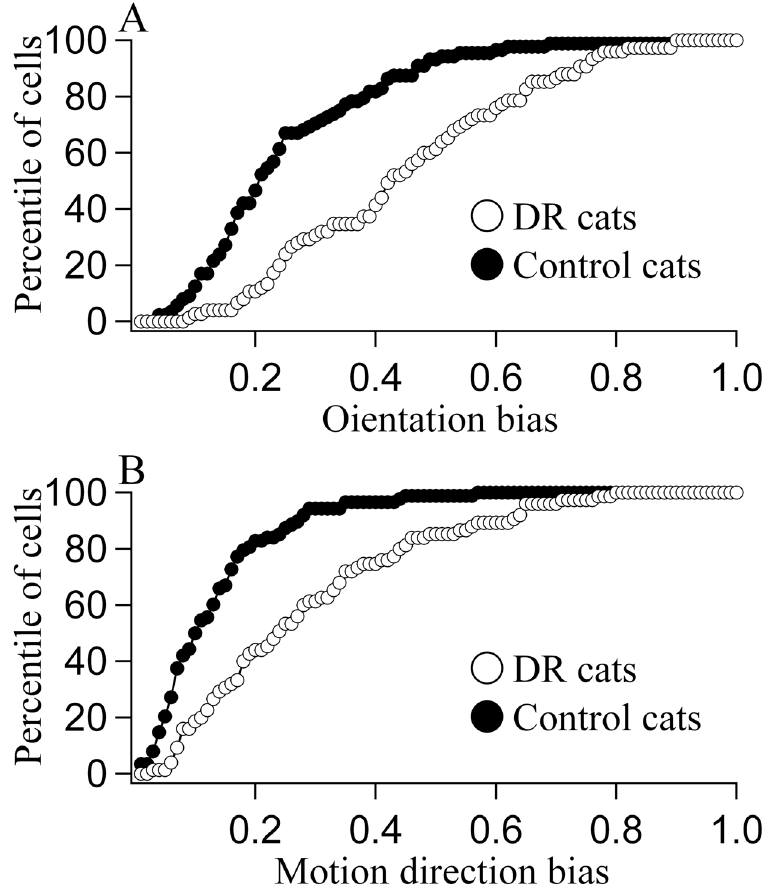
Fig 4. Percentile value of neurons showing different orientation bias (OB) (A) and motion direction bias (DB) (B) for DR cats (open circle) and normal control cats (solid circle). The total number of neurons was 75 and 88 respectively for DR cats and control cats. A percentile value indicated the percentage of neurons whose OBs or DBs were lower than the corresponding OB or DB value on the horizontal axis. DR cats showed significantly increased OB and DB value compared with control cats (p < 0.0001; p <